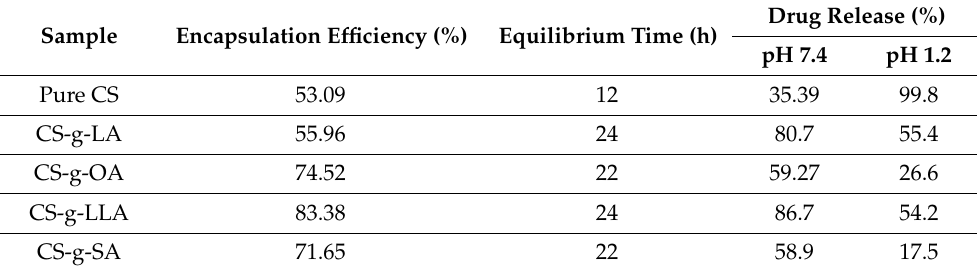
Table 2. Comparison of encapsulation efficiency (%), equilibrium time (h), and release at two different pHs for the insulin